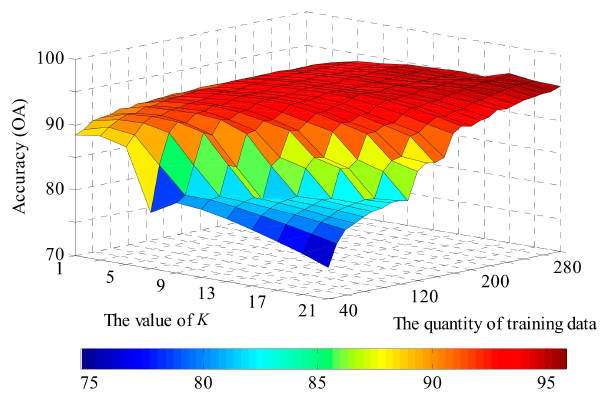
Figure 10. The accuracy of KNN method over different values of the K parameter and training data sample scales.